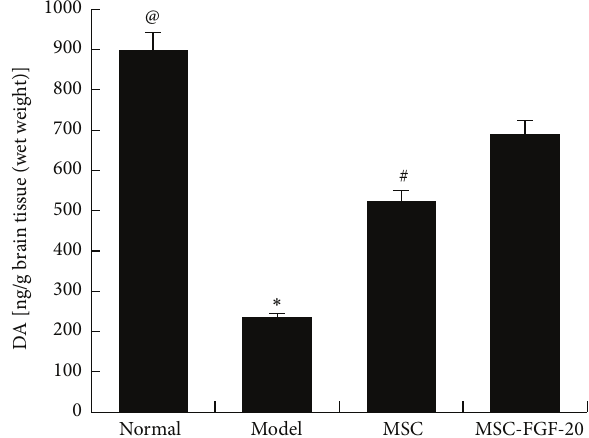
Figure 4: The level of DA in the corpus striatum of PD mice. DA level was greatly decreased in the model group, whereas it was obviously increased after hUC-MSC and hUC-MSC-FGF-20 treatments ( @ 𝑝 < 0.01 , the normal group versus the model group; ∗ 𝑝 < 0.01 , the model group versus MSC and MSC-FGF-20 group; # 𝑝 < 0.05 , MSC group versus MSC-FGF-20